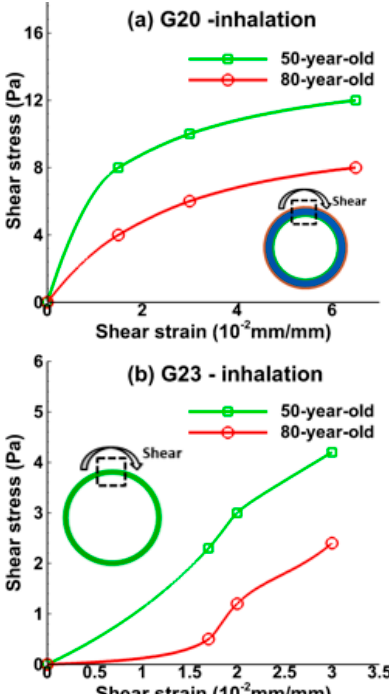
Figure 6. Relationship between shear strain and shear stress during mid ‐ point of inhalation (t = 0.2 s) at ( a ) the bronchiole (G20) and ( b ) the alveolar sac (G23) tissue for the 50 ‐ year ‐ old and 80 ‐ year ‐ old.